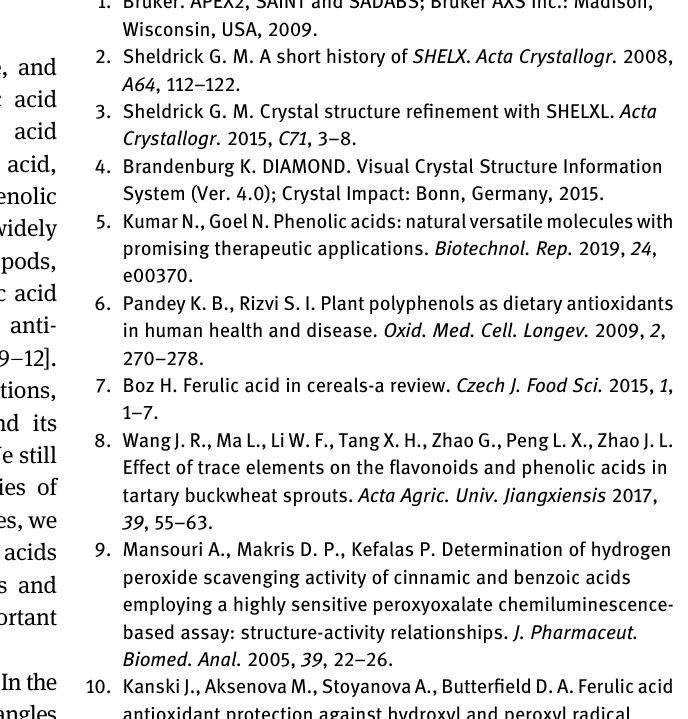
within methyl 4-acetoxy-3-methoxybenzoate are very similar to those given in the literature [17, 18]. In the title structure, the part of methyl 4-hydroxy-3-methoxybenzoate is approxi- mately planar. The dihedral angle formed by the C1 – C6 plane with the carboxylate group O1 – C7 – O2 plane is 6.5 ° . The acetyl group O4 – C10 – O5 plane is perpendicular to methyl p -hy- droxy-3,5-dimethoxybenzoate and the dihedral angle is 73.5 ° . The torsion angles of C1 – C2 – O3 – C9, C1 – C6 – C7 – O2, C6 – C7 – O2 – C8, C2 – C3 – O4 – C10 and C3 – O4 – C10 – C11 are 0.0(3) ° ,